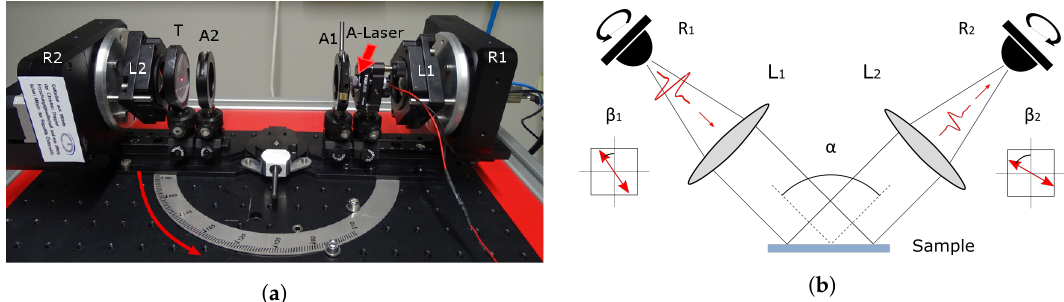
Figure 1. ( a ) Photography of the setup with the reflection guide open at 180 ◦ and all the elements in place for the second step of the alignment procedure: fiber-based PCAs mounted in rotation stages ( R 1 , R 2 ), lenses for beam collimation ( L 1 , L 2 ), irises ( A 1 , A 2 ), aiming laser ( A -Laser) and target ( T ). ( b ) Schematic representation of the setup after alignment, positioned for a measurement in